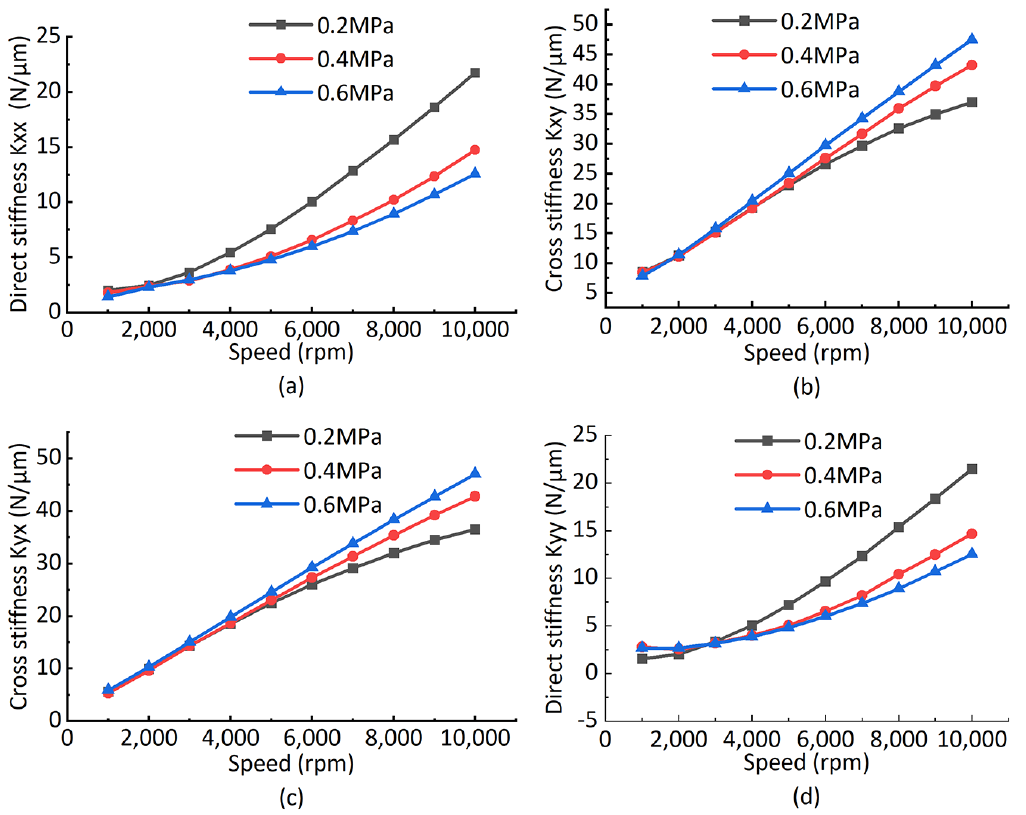
Figure 9. Bearing stiffness curve at different rotor equilibrium positions: ( a ) direct stiffness in X direction; ( b ) cross stiffness in X direction; ( c ) cross stiffness in Y direction; ( d ) direct stiffness in X